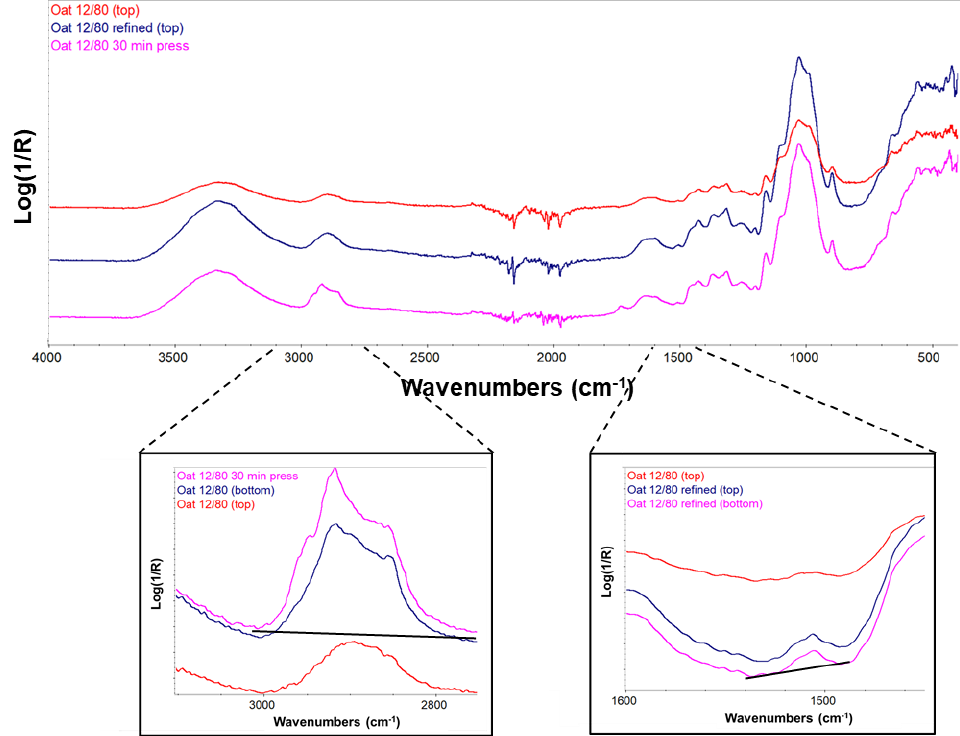
Figure 7. Comparison of IR spectra of different types of Oat 12/80 sheets. The IR spectrum of the top side of the unrefined Oat 12/80 sheet (red curve) shows cellulose only. The IR spectra of the bottom side of this sample and the sheet with 30-min hot pressing (left blowup) show additional weak bands of long hydrocarbon chains in the wavenumber range of 2800–3000 cm −1 . This explains the higher values of the contact angles for the latter cases in Table 4. A small proportion of lignin is seen in the refined Oat 12/80 sheet on both sides, as the IR spectra show a small band of the aromatic ring near the wavenumber of 1510 cm −1 (right blowup).